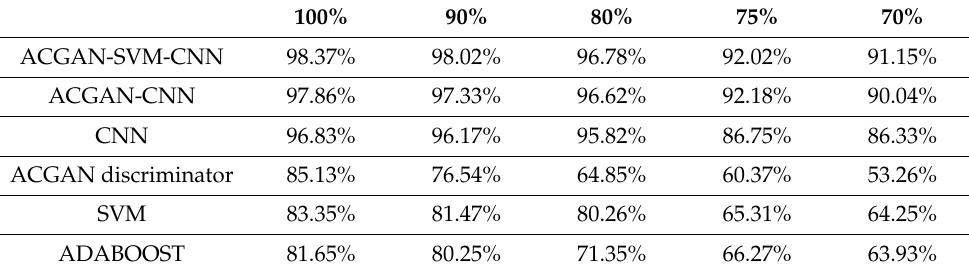
Table 6. Performance of different models under different amount of training